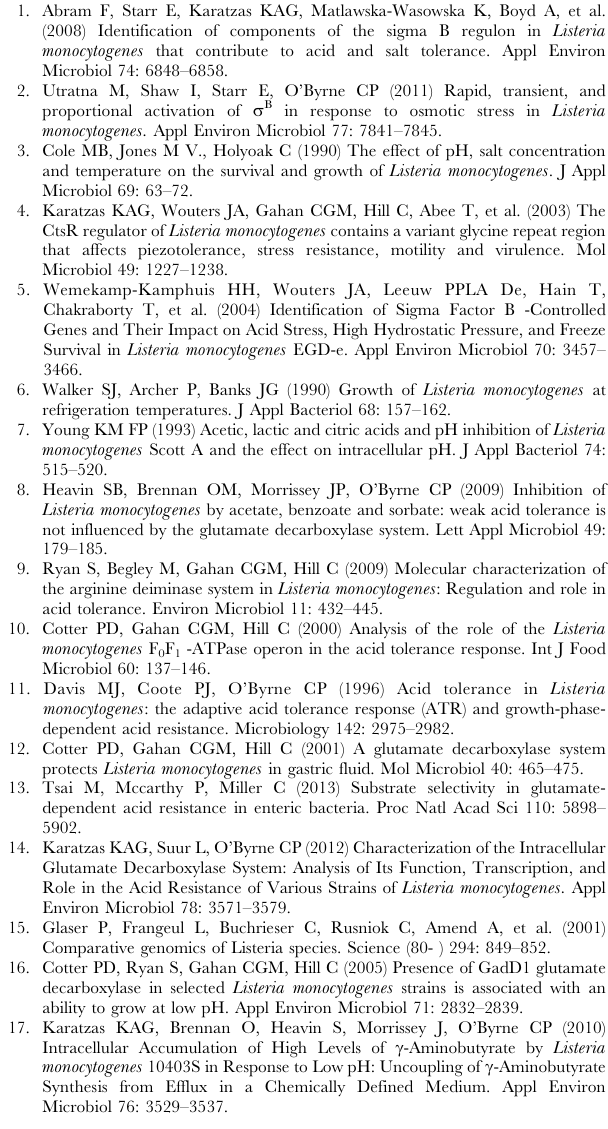
Figure S1 Acid survival of L. monocytogenes gad mutants. Mid-log phase EGDm (a) and 10403S (b) D gad mutants were challenged at pH 3.0. Cell counts were taken every 20 min. Values are the means of data from three individual cultures, with the cell counts for each culture being the means of counts from three platings. Error bars represent the standard error from the mean value of three individual biological repeats. Figure S2 GABA production from L. monocytogenes gad mutants. (a) Production of GABA e by EGDm and 10403S gad mutants with (grey) or without (black) 1 h exposure to acid at pH 4.0 (EGDm) or pH 3.5 (10403S). (B) Production of GABA i by EGDm and 10403S gadD mutants with (grey) or without (black) 1 h exposure to acid at pH 4.0 (EGDm) or pH 3.5 (10403S). Dashed horizontal lines indicate the detection limits for GABA in each